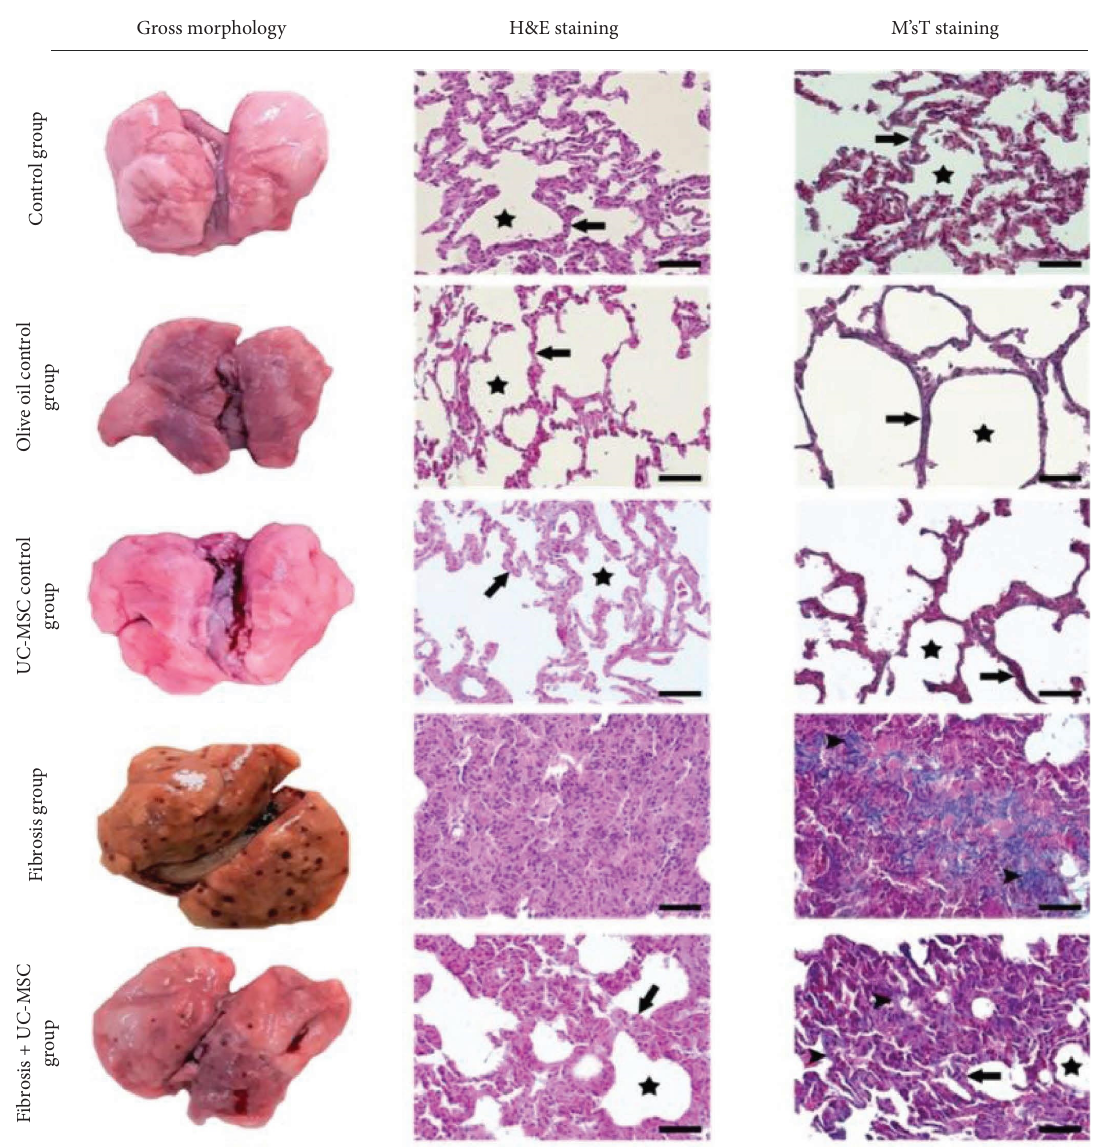
Figure 1: Te results of histological examination of the lung tissue with H&E and M’sTstaining; (magnifcation � 400x, scale bar � 50 μ m). C: control group, C.O: olive oil control group. C.Ms: hMSC-CM control group, Fb: fbrosis group, Fb.Ms: group Fb with hMSC-CM treatment. Te black arrow ( ↑ ) shows the alveolar wall, the black asterisk ( ∗ ) shows alveoli, and the black arrowhead ( ► ) shows collagen signifcantly decreased in group Fb.Ms compared to the (Figure 2(e), p < 0 . 01) were signifcantly lower in group group C.Ms (Figures 2(a), 2(c) and 2(e), p < 0 . 05). Fb.Ms than in group C.O. Furthermore, the TOS and MDA levels signifcantly increased, and the GSH level